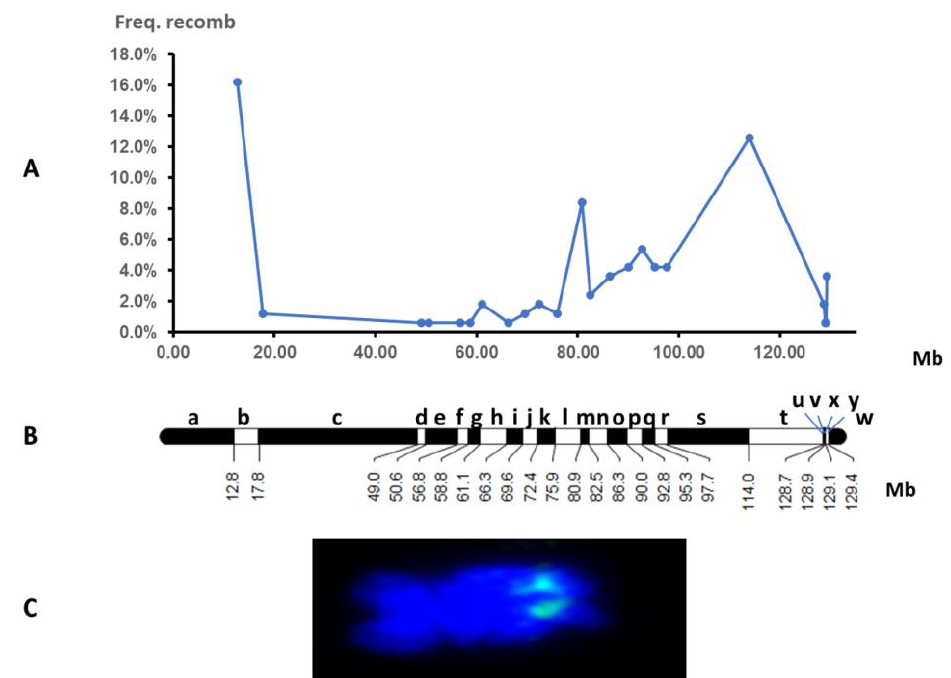
Figure 4. ( A ) Distribution of recombination frequency between bins along chromosome 5 of A. officinalis . ( B ) Map bins. ( C ) Fluorescence in situ hybridization (FISH) with rDNA 45s probe on chromosome 5 [18].